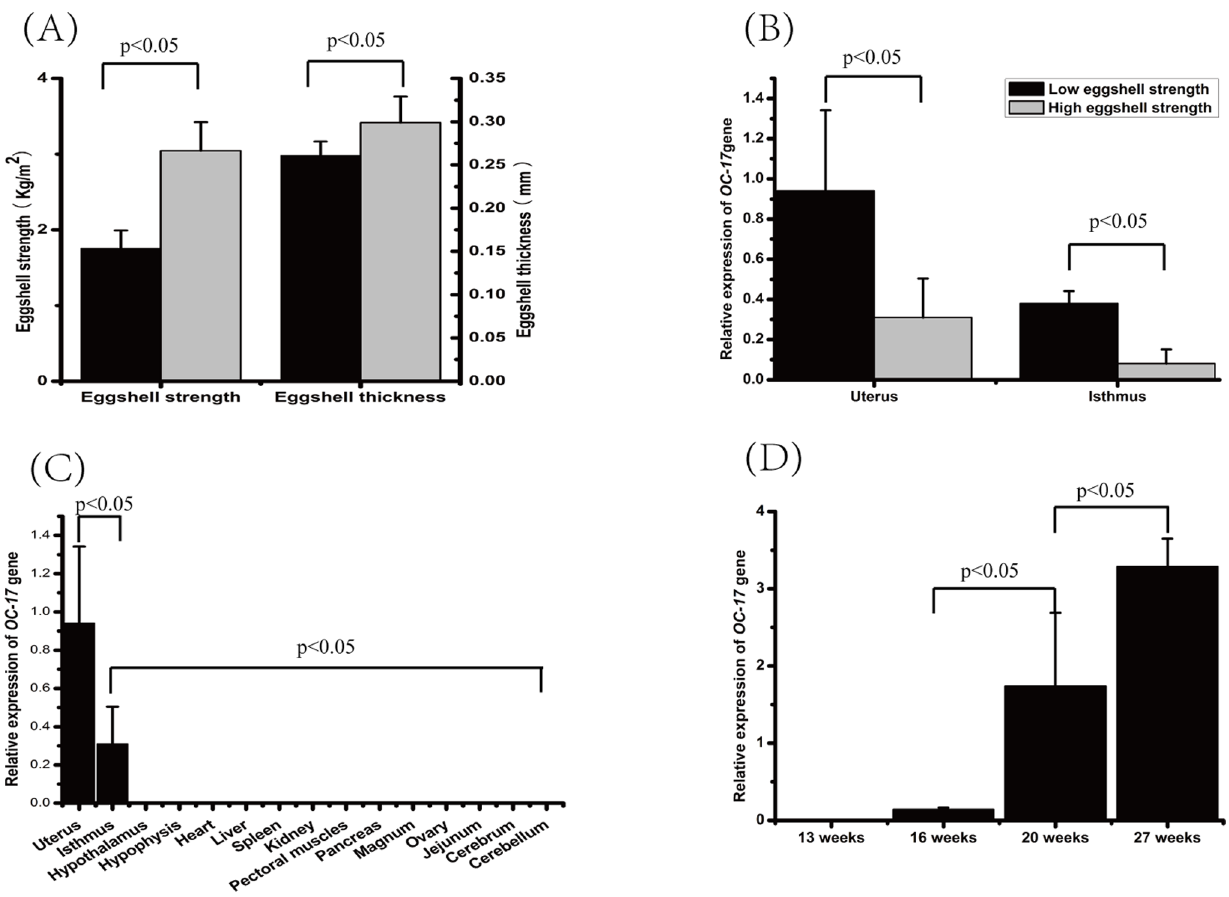
Figure 3. Eggshell biomechanical measurements and expression analysis of Ovocleidin-17. (A) Eggshell phenotypes showed significant differences between the two tails of the eggshell strength groups; (B) the OC-17 mRNA expression levels were significantly higher in hen uterus and isthmus in the low eggshell strength groups compared with the high eggshell strength groups; (C) OC-17 mRNA can only be detected in hen uterus and isthmus among the 15 sampled adult hen tissues. One way ANOVA analysis suggested there were significant expression differences among different tissues. OC-17 showed a much higher expression level in uterus than in other tissues (pairwise t-test, P value , 0.05); (D) One way ANOVA analysis suggested that significant expression differences existed among different stages. OC-17 showed an increasing pattern of expression between the immature and mature laying stages (pairwise t-test, P value , 0.05).